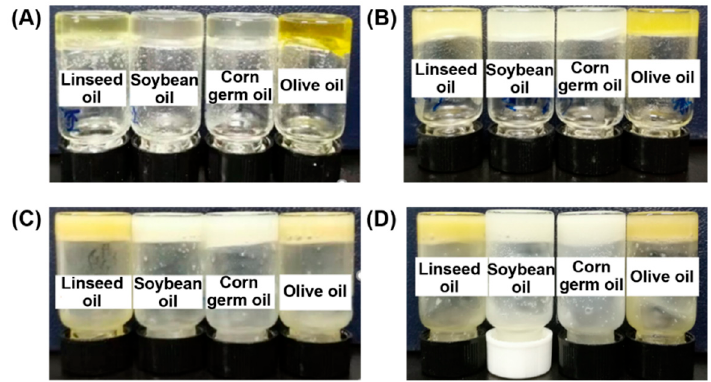
Figure 1. Oleogels formed by lysine-based gelators in linseed oil, soybean oil gel, corn germ oil and olive oil: ( A ) C8-lys-C8, ( B ) C10-lys-C10, ( C ) C12-lys-C12, ( D ) C14-lys-C14. olive oil: ( A ) C8-lys-C8, ( B ) C10-lys-C10, ( C ) C12-lys-C12, ( D )